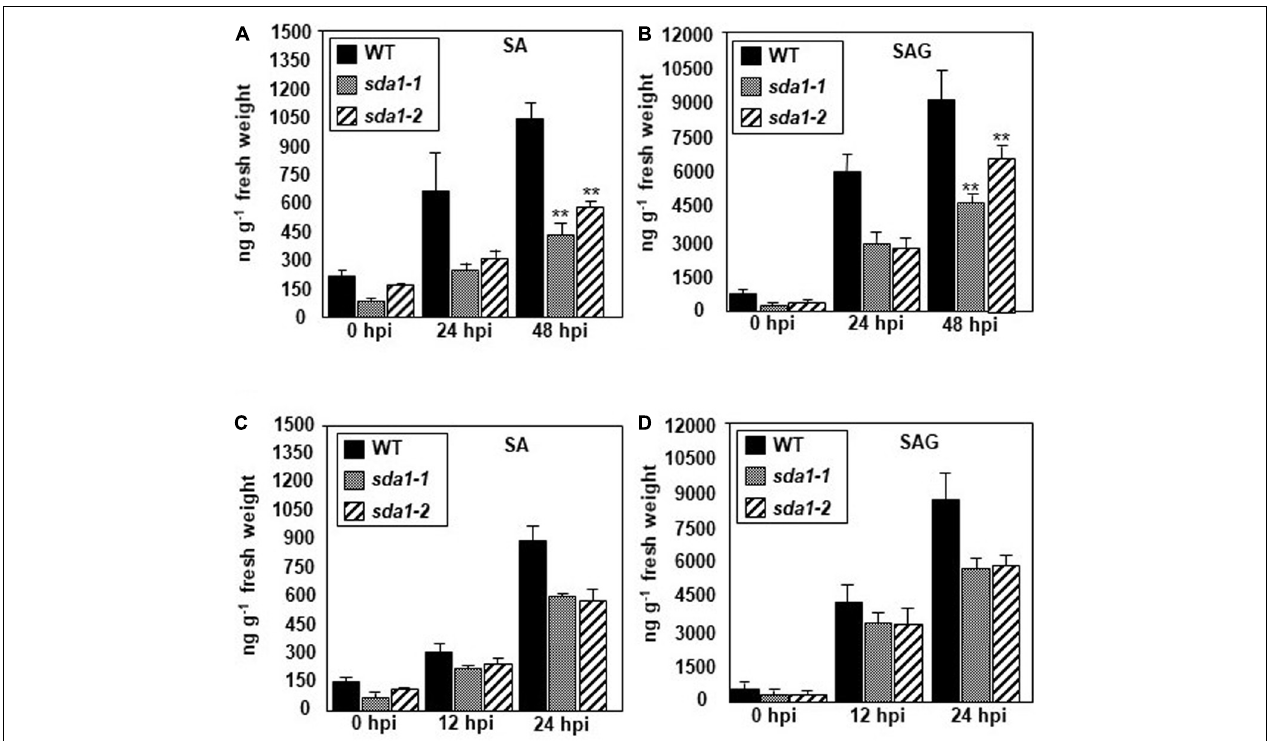
FIGURE 4 | sda1 mutant is compromised in accumulating pathogen-inducible SA and SAG. Rosette leaves of 4-week-old plants of wild-type (WT) and sda1 mutants were inoculated with Pst DC3000 (A,B) and Pst DC3000 (avrRpm1) (C,D) at a titer of 5 × 10 7 cfu/mL in 10 mM MgSO 4 . Tissue samples were collected at the indicated hpi and free SA (SA) and glucose-conjugated SA (SAG) were extracted. The values are means ± SD of three replicates, each consisting of leaves from 10 plants per genotype. Statistical analysis was performed by one-way ANOVA followed by Dunnett’s test with reference to WT control. Asterisks indicate statistically significant differences (** p <